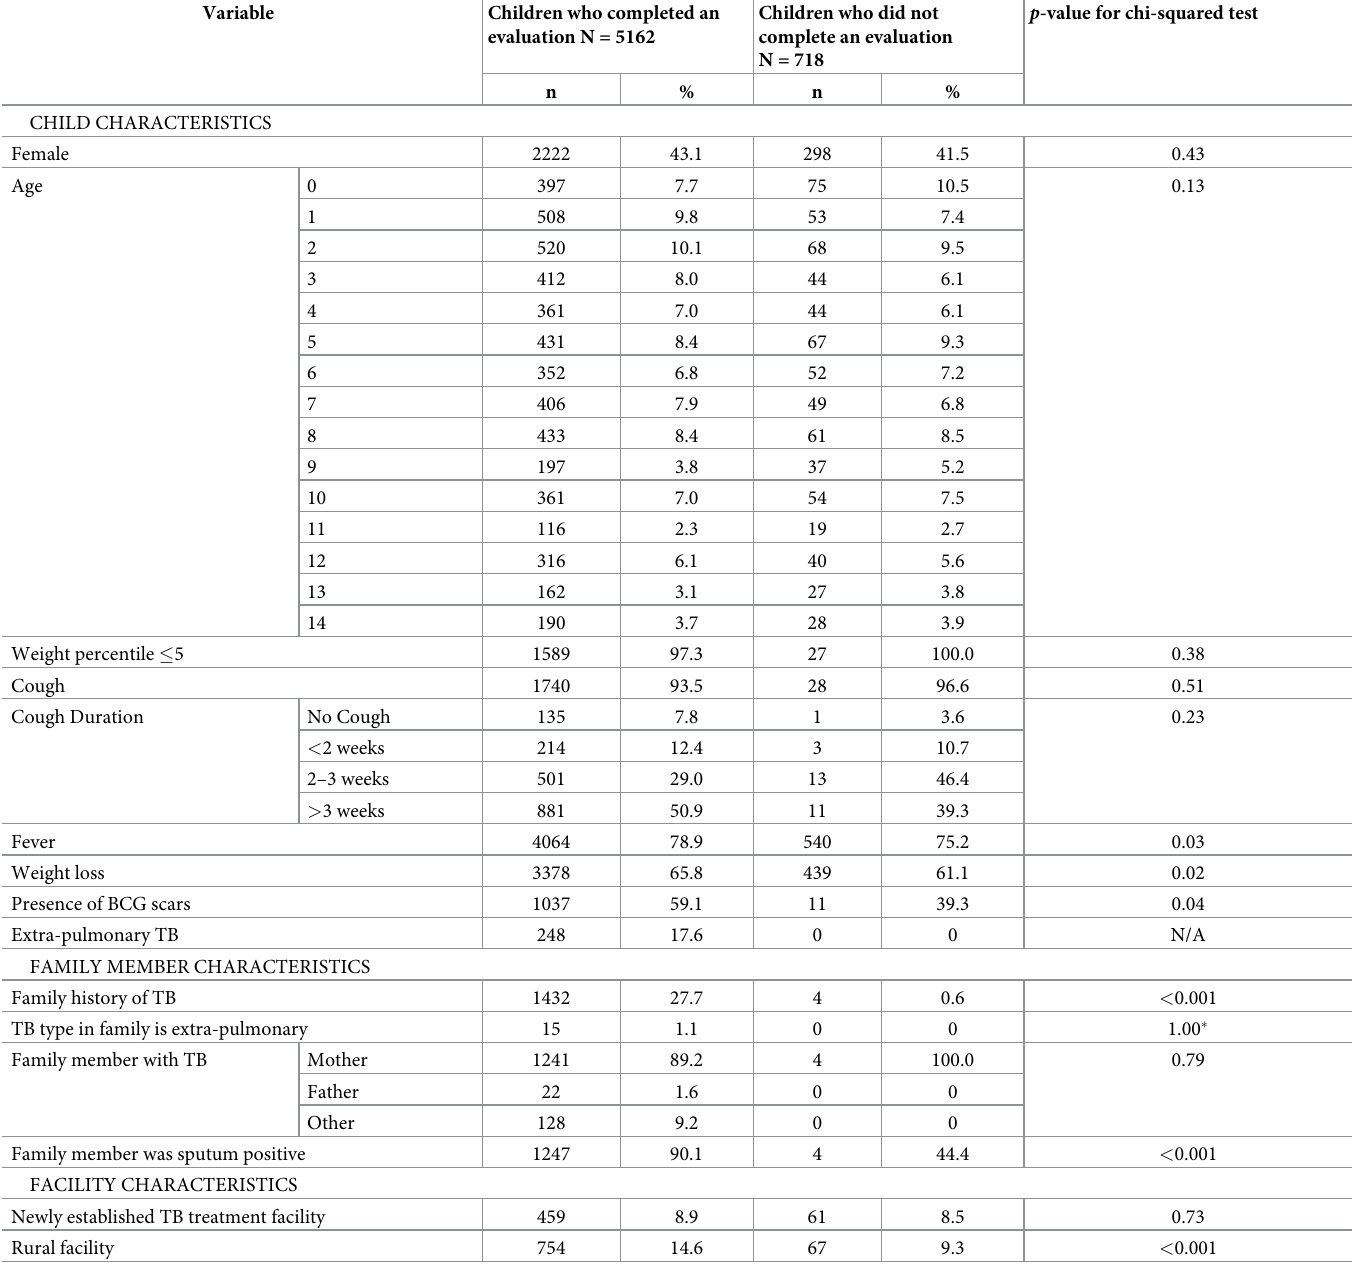
Table 1. Characteristics of children who were evaluated for TB compared to children who were not evaluated for TB. Variable Children who completed an evaluation N =